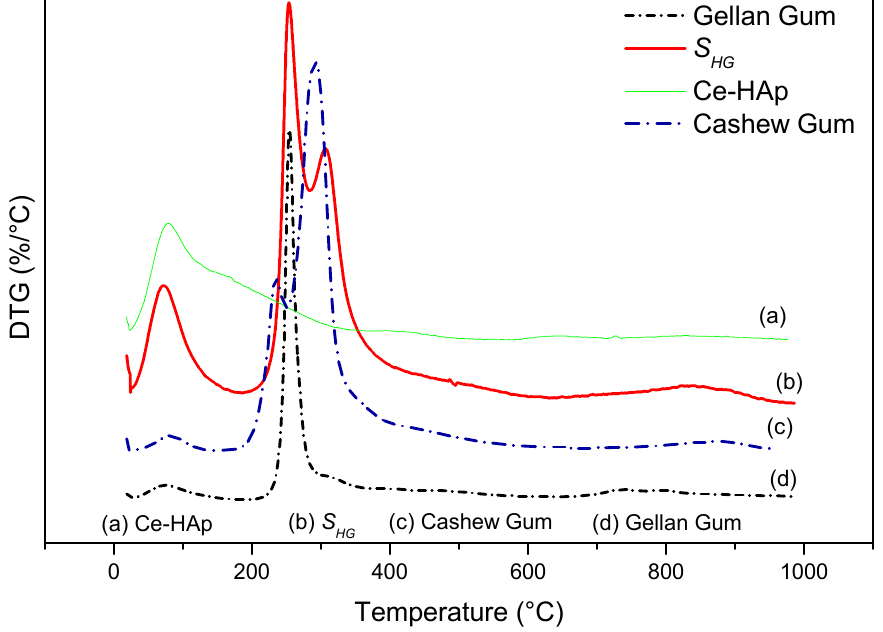
Figure 8. DTG of (a) Ce-HAp, (b) S HG , (c) cashew gum, and (d) gellan gum.